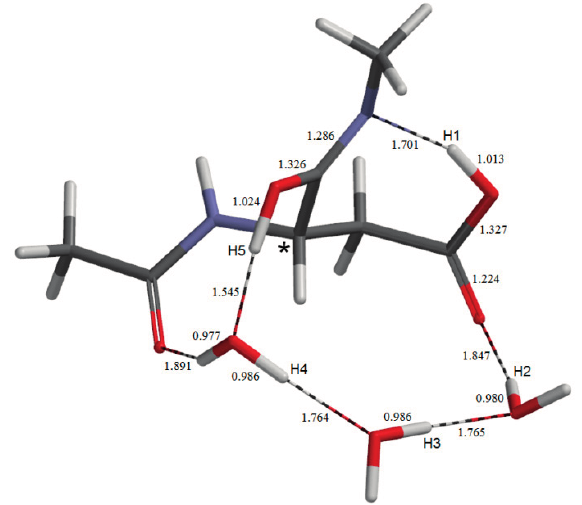
Figure 6. The geometry of the second intermediate IM1 . Selected bond distances are shown in Å.